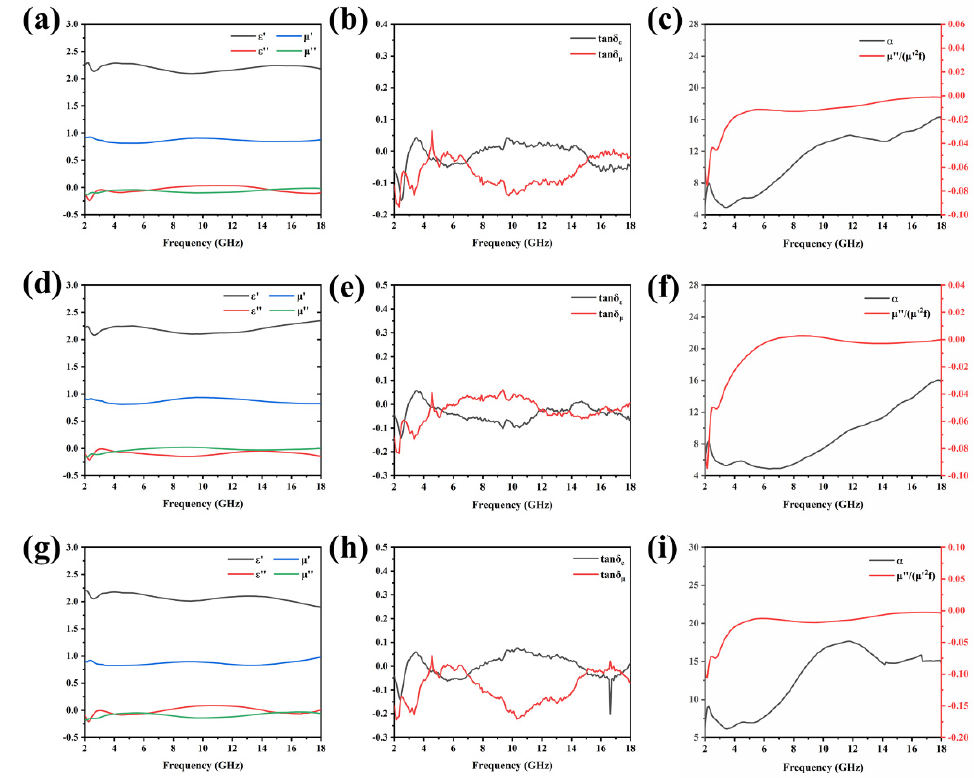
Figure 4. Relevant EM parameters of Co 2 SiO 4 @DE-3 ( a – c ), Co 2 SiO 4 @DE-6 ( d – f ), and Co 2 SiO 4 @DE- 12 ( g – i ). Frequency dependence of ε (cid:48) , ε (cid:48)(cid:48) , µ (cid:48) , and µ (cid:48)(cid:48) ( a , d , g ); dielectric and loss tangent ( b , e , h ); and attenuation constant α and µ (cid:48)(cid:48) ( µ (cid:48) ) 2 f − 1 values ( c , f , i